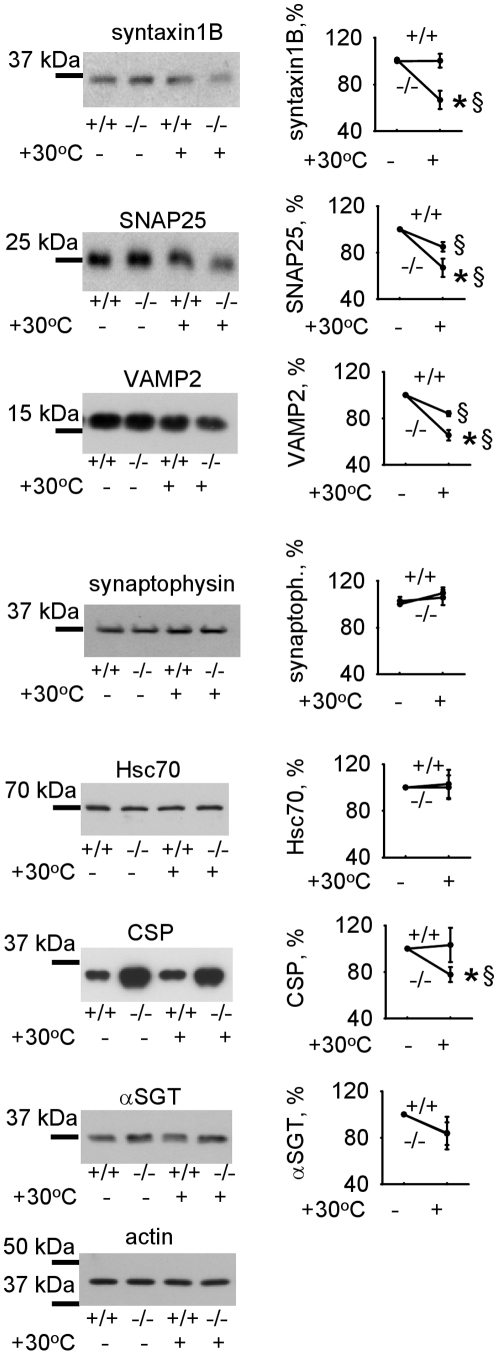
CHL1 deficiency results in the increased degradation of the SNARE complex proteins under elevated temperatures.CHL1+/+ and CHL1−/− brain homogenates either freshly prepared or pre-incubated at 30°C for 30 minutes were probed by Western blot with the indicated antibodies. Note a more pronounced decline in the levels of syntaxin1B, SNAP25 and VAMP2, but not synaptophysin in heat-exposed CHL1−/− versus CHL1+/+ brain homogenates. Levels of Hsc70, CSP and αSGT are similar or higher in CHL1−/− versus CHL1+/+ brain homogenates exposed to 30°C. Actin served as a loading control. Graphs show mean optical density of the blots ± SEM (n = 6) with optical density in non-treated homogenates set to 100%. *, § p<0.05, paired t-test (CHL1−/− versus CHL1+/+ heat-treated brain homogenates (*), and non-treated versus treated groups of the same genotype (§) were compared).